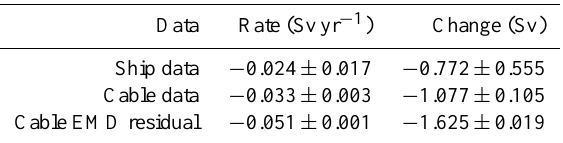
Table 2. Linear models of Florida Current transport rates and change over the period of record (March 1982–November 2014) from ship and cable